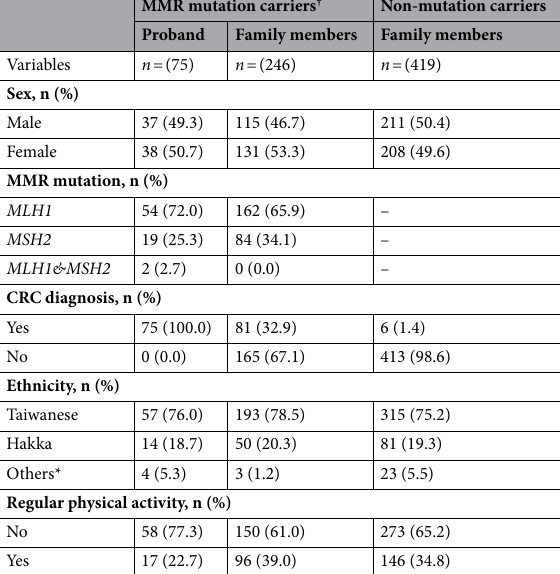
Table 1. Characteristics of the study sample. MMR ; Mismatch repair genes. † Including MLH1 and MSH2. *Including Mainland Chinese and